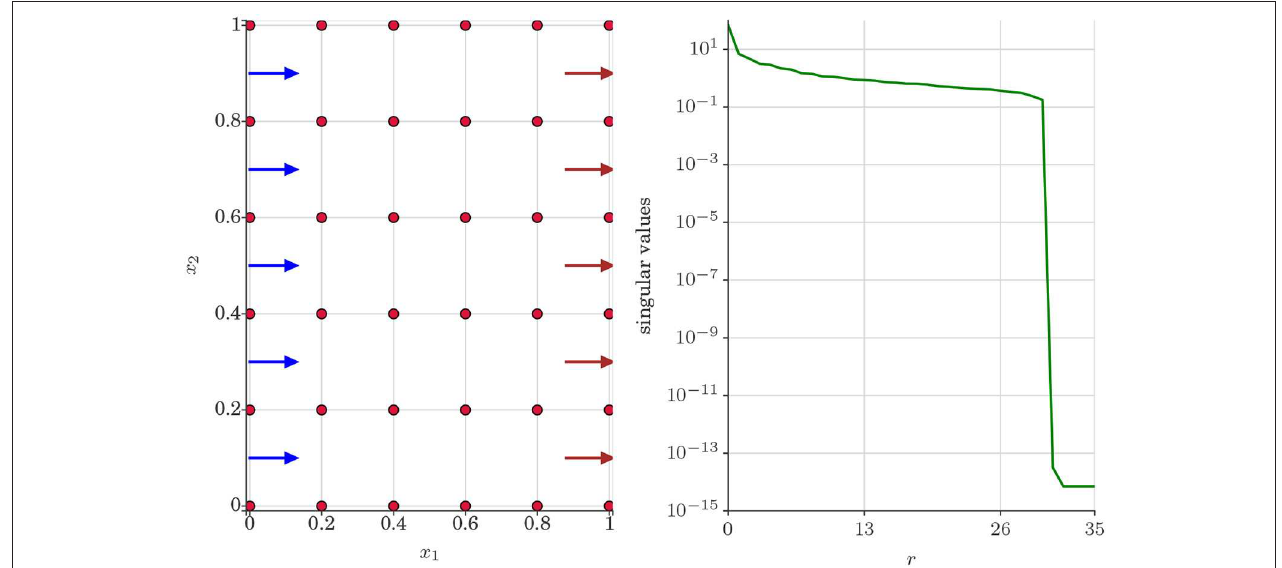
FIGURE 7 | Test case 2: (Left) Uniform flow problem set up where water is injected from the left side denoted by blue arrows. Oil and water are produced from the right side denoted by brown arrows. The red dots denotes the spatial locations of the porous media domain where the statistics of the QoI u are investigated. (Right) Decay of singular values of the snapshot matrix X u .